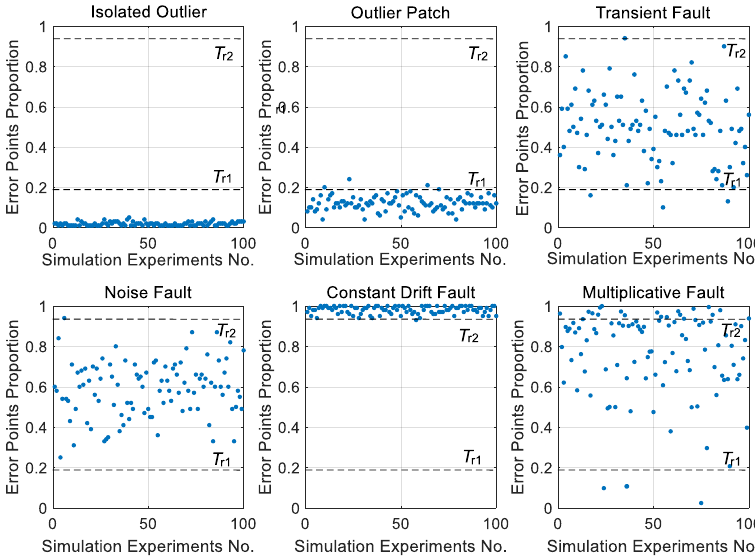
Figure 8. The distribution of the proportion of error points in different situations. Table 2. The distribution of the proportion of error points in different situations.